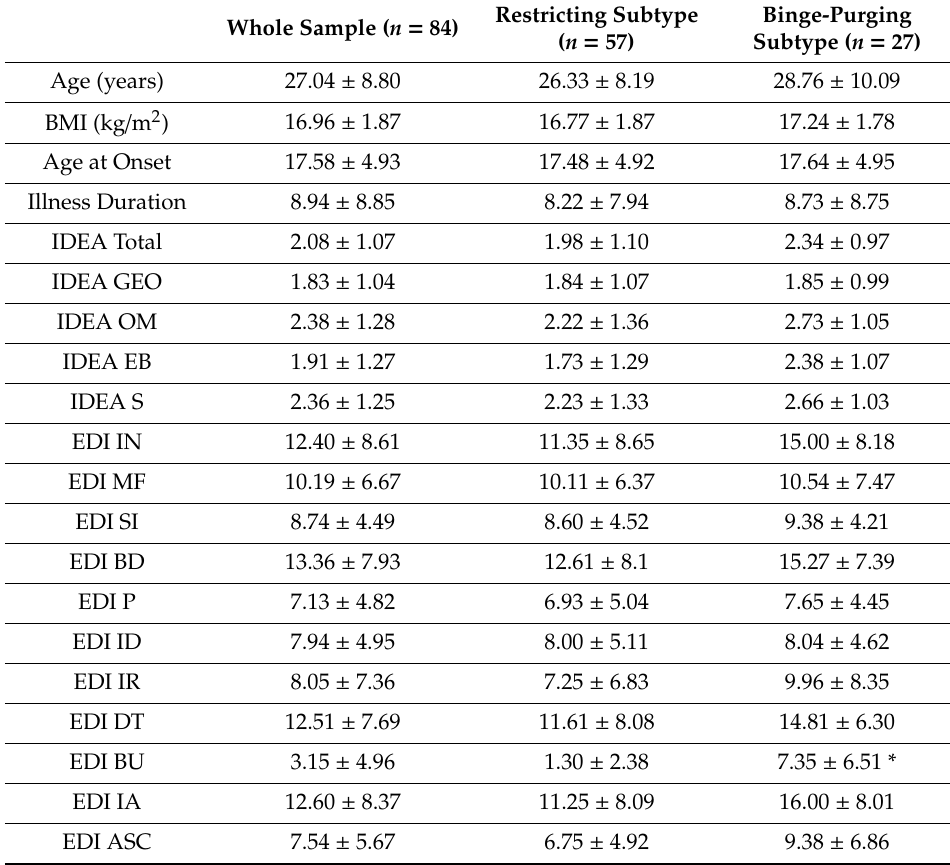
Table 1. Demographic and clinical characteristics of the whole sample and diagnostic subtype groups (means ± standard